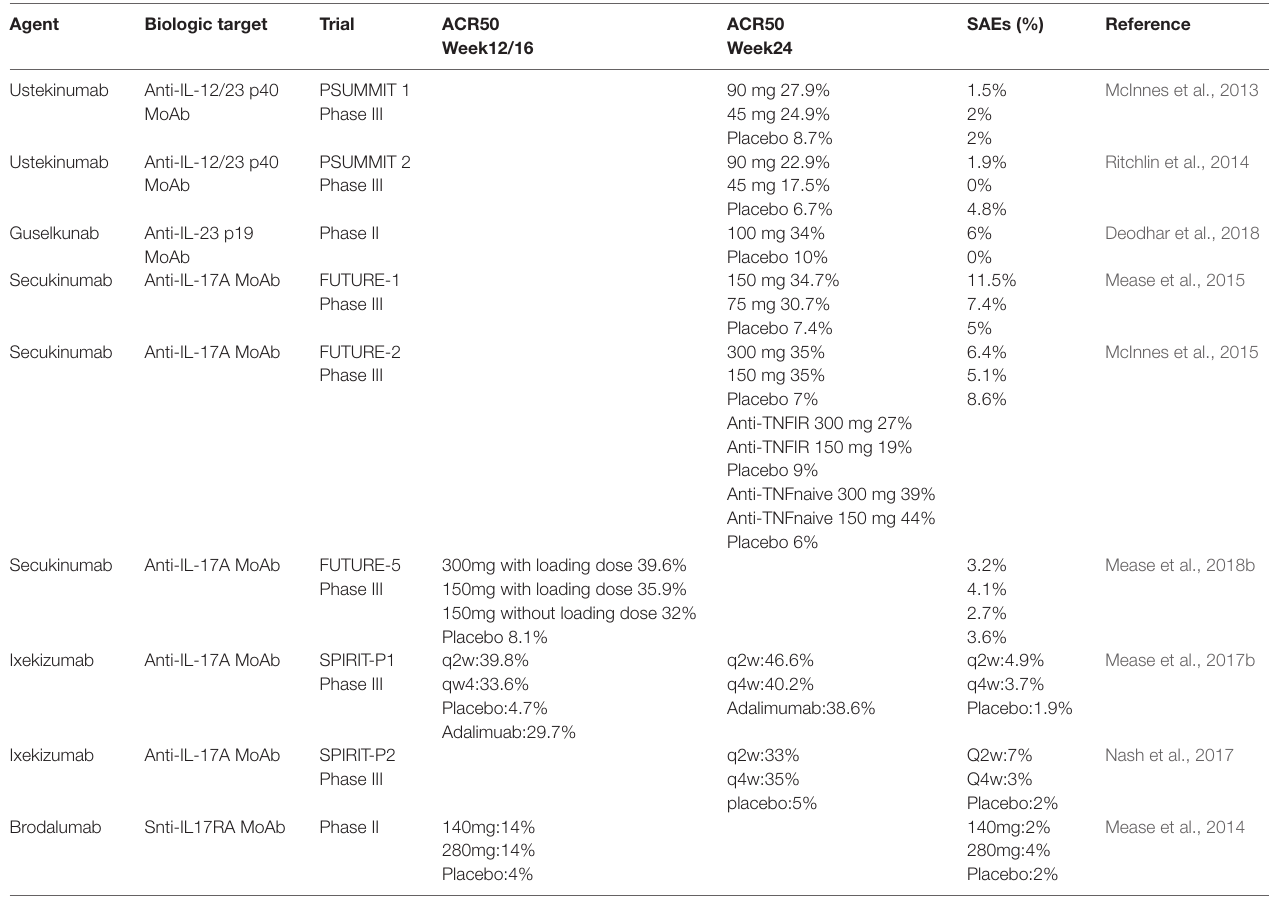
TABLE 1 | Major clinical trials of trreatments targeting the IL-23/IL-17 axis and their main efficacy and serious adverse events characteristics in patients with psoriatic